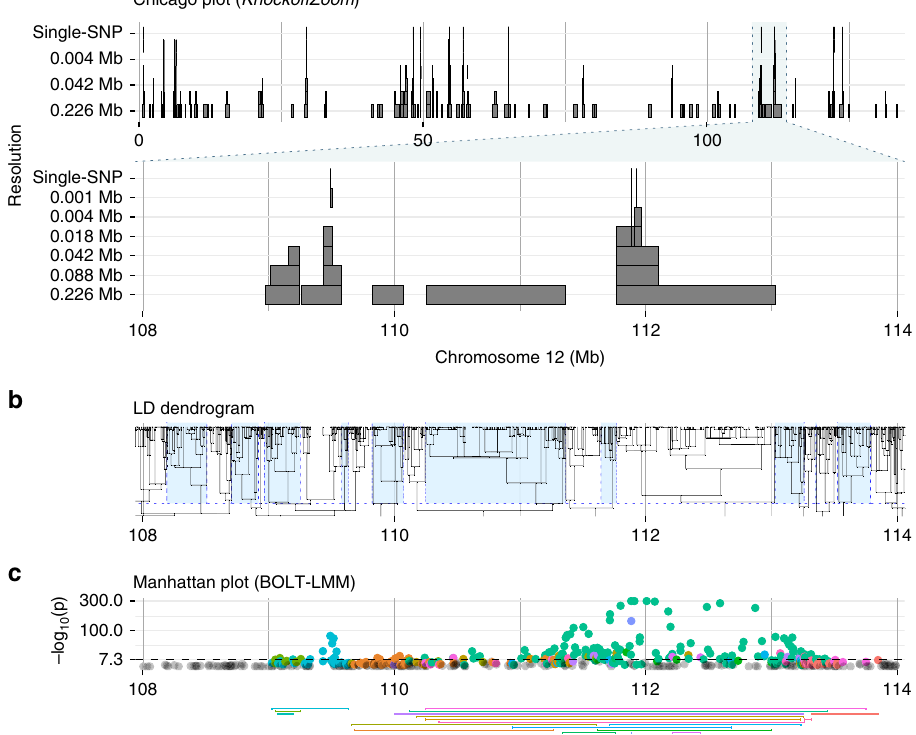
Fig. 1 Discoveries for platelet count. KnockoffZoom discoveries a on chromosome 12 for the phenotype platelet in the UK Biobank, controlling the FDR below 0.1. Each shaded rectangle represents a discovery at the resolution indicated by its vertical position (measured by the average width of the blocks), so that the highest-resolution fi ndings are on top. The lower part of a focuses on a smaller genomic region. The hypotheses are prespeci fi ed by cutting the LD dendrogram b at different heights. As an example, by alternating blue and white shading in ( b ), we indicate the lowest-resolution blocks. The Manhattan plot c shows the BOLT-LMM p values from the same data, while the segments below represent the region spanned by the signi fi cant discoveries clumped with PLINK at the genome-wide signi fi cance level (5 × 10 − 8 ). For each clump, the colors match those of the corresponding p values. All plots are vertically aligned, except for the top part of ( a